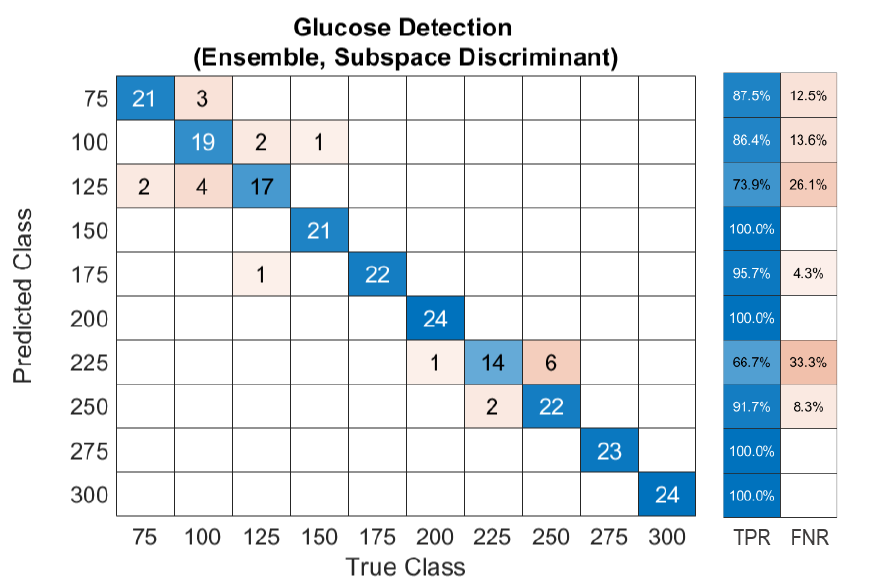
Figure 12. Confusion matrix of the ensemble model trained with preprocessed data of glucose